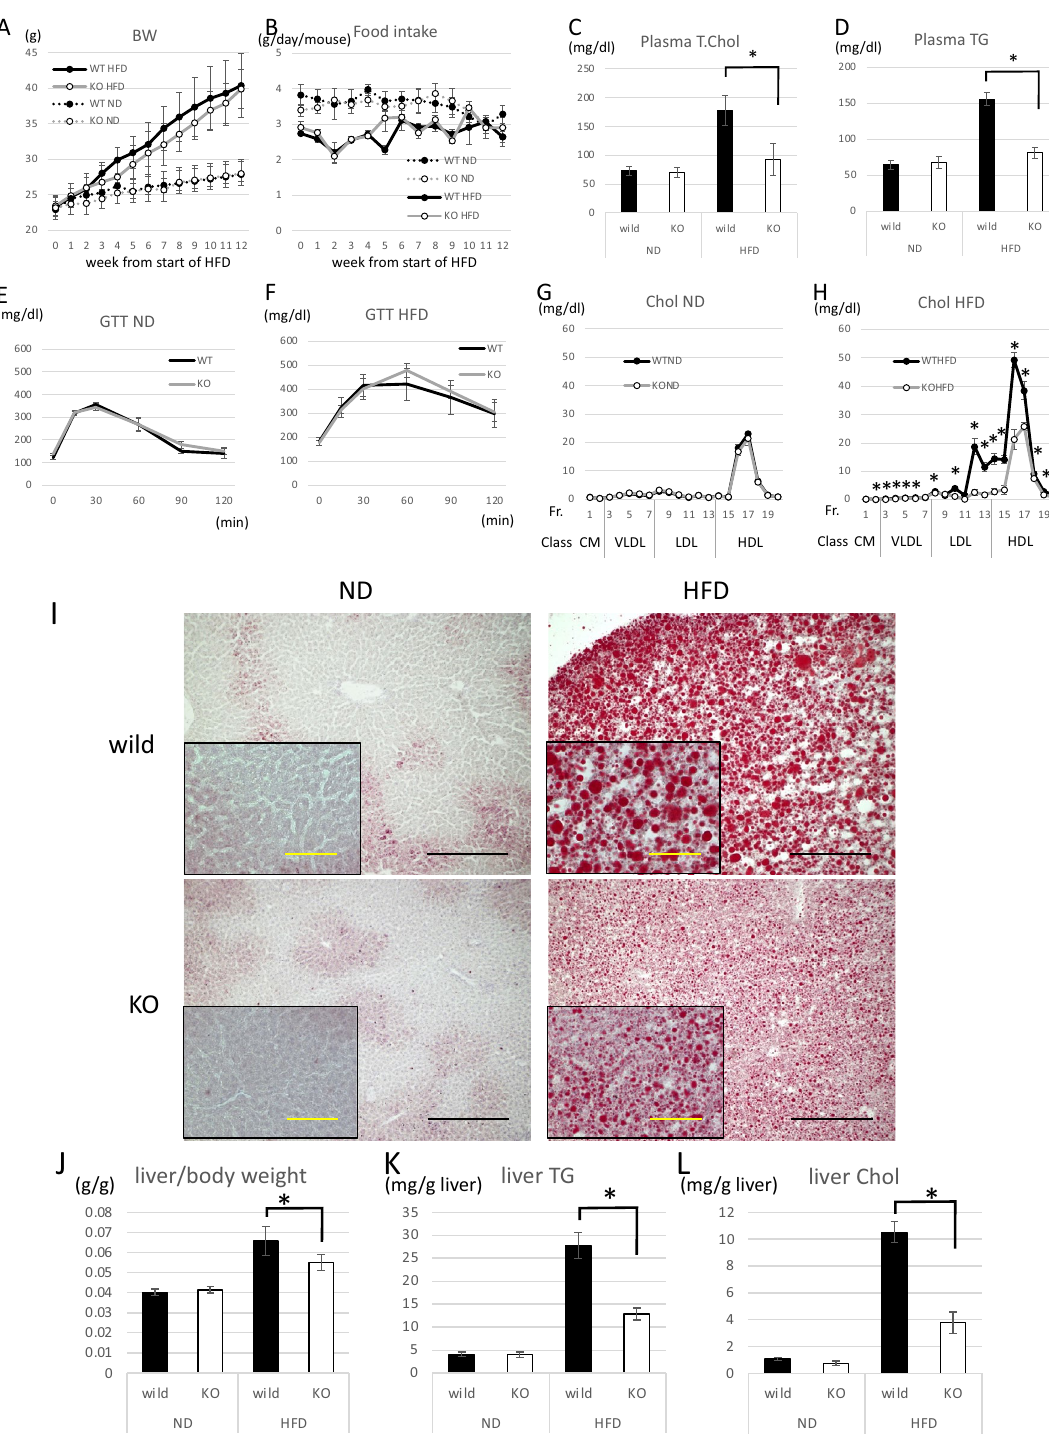
Figure 2. Phenotype characterization of Gpr180 KO mice. ( A ) Body weight and ( B ) Food intake of wild-type and Gpr180 KO (KO) mice fed high-fat diet (HFD) or normal diet (ND) for 12 weeks. Data are presented as means with standard deviation (n = 7). ( C ) Plasma cholesterol and ( D ) triglyceride (TG) levels in mice fed the indicated diets for 12 weeks and starved 4 h prior to sample harvesting. Data are presented as means with standard deviation (n = 7). ( E ) Intraperitoneal glucose tolerance test (IP-GTT) in 20-week-old male mice fed ND (n = 6). ( F ) IP-GTT in 20-week-old mice fed HFD (n = 6). ( G ) Cholesterol levels in HPLC-fractionated plasma of wild-type and KO mice fed ND (n = 4) or ( H ) HFD (n = 4). ( I ) Representative Oil Red O staining of 20-week-old mouse liver fed ND or HFD. Black and yellow scale bars indicate 100 and 20 μm, respectively. ( J ) Liver weight per body weight of wild-type and KO mice fed ND or HFD (n = 8). ( K ) TG and ( L ) cholesterol contents in liver extract (mg/g) of wild-type and KO mice fed ND or HFD (n = 8). *p <